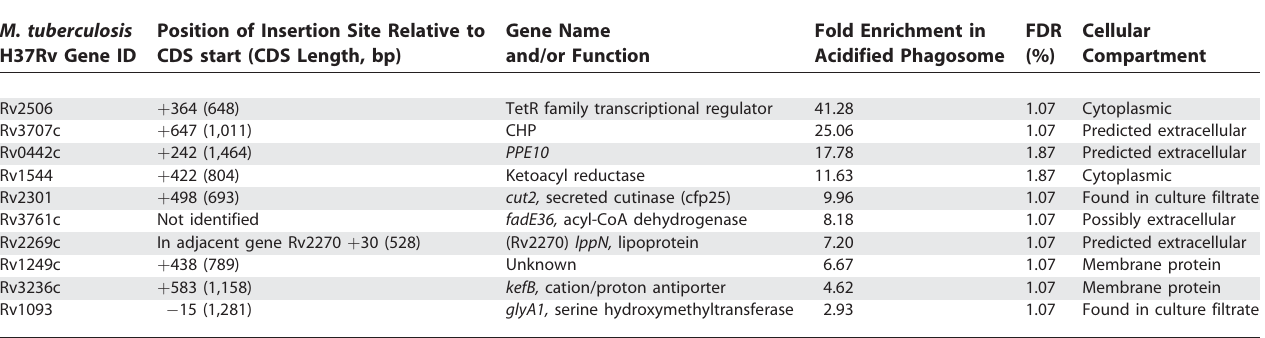
Table 2. The Ten Mutants Most Significantly Enriched in Acidified Phagosomes M. tuberculosis Position of Insertion Site Relative to H37Rv Gene ID CDS start (CDS Length, bp)